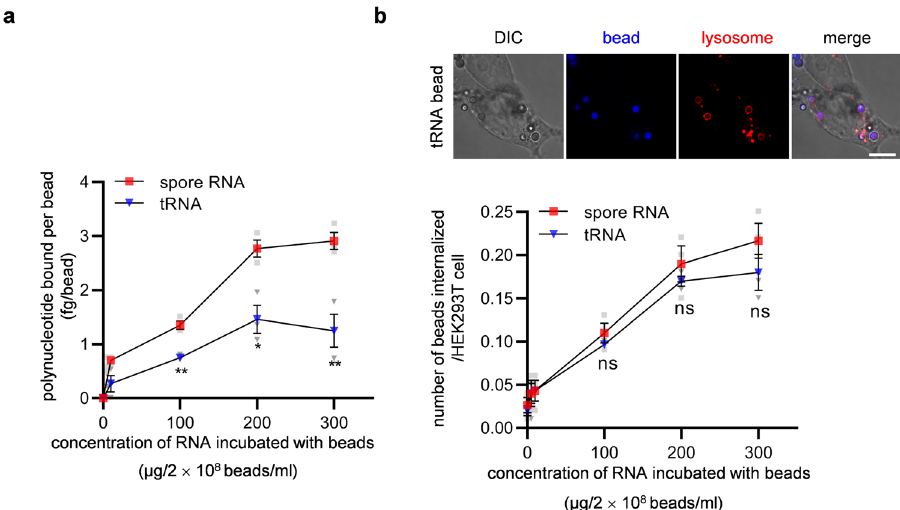
Fig. 3 RNA induces phagocytosis by NPPs. a Amounts of RNA bound to latex beads. Spore wall-derived RNA (spore RNA) or tRNA were incubated with latex beads at the indicated concentrations, and amounts of RNA bound to the beads were measured. b Internalization of RNA-bound latex beads in HEK293T cells. Upper panels: Representative images of cells with internalized tRNA-bound latex beads. Scale bar, 10 µ m. Lower panel: The indicated RNA- bound latex beads were incubated with HEK293T cells at the indicated concentrations. Mean numbers of beads internalized per HEK293T cell are shown. Data were presented as the mean ± SEM. Statistical signi fi cance was determined by two-tailed unpaired Student ’ s t -tests. n = 3. * P < 0.05; ** P < 0.01; ns not signi fi cant ( P ≥